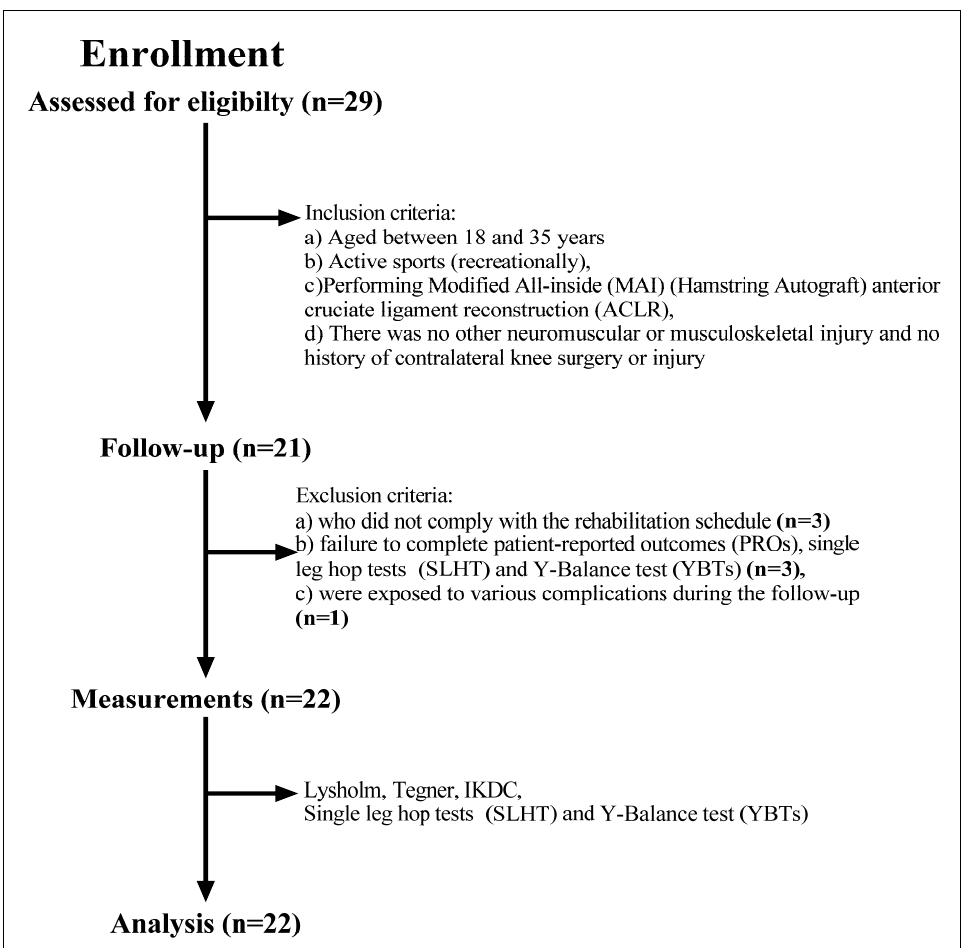
Figure 1. Flow chart diagram: description of the study population and inclusion and exclusion cri ‐